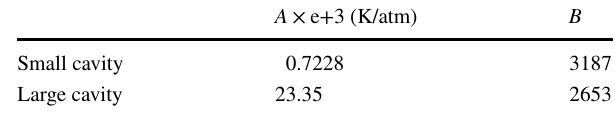
Table 1 Coefficients of Langmuir